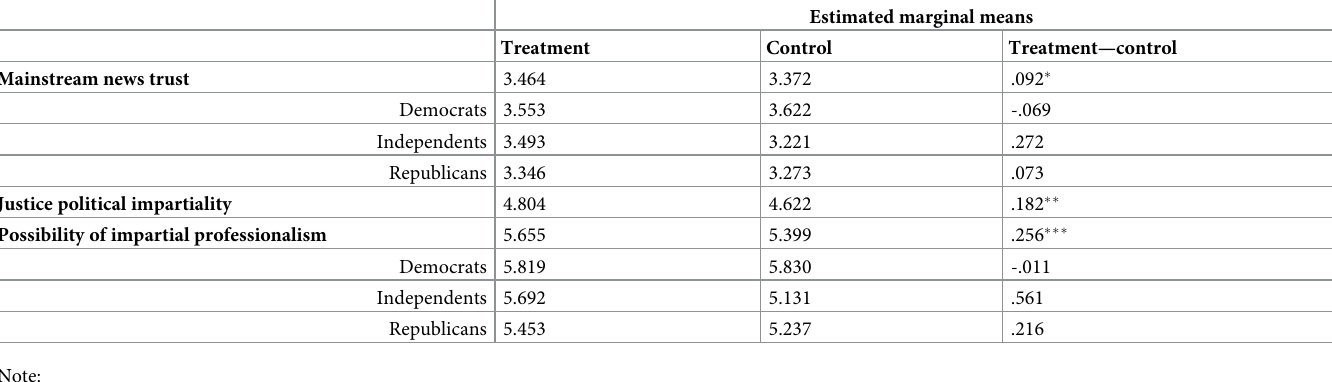
Table 1. Study 1 treatment mean